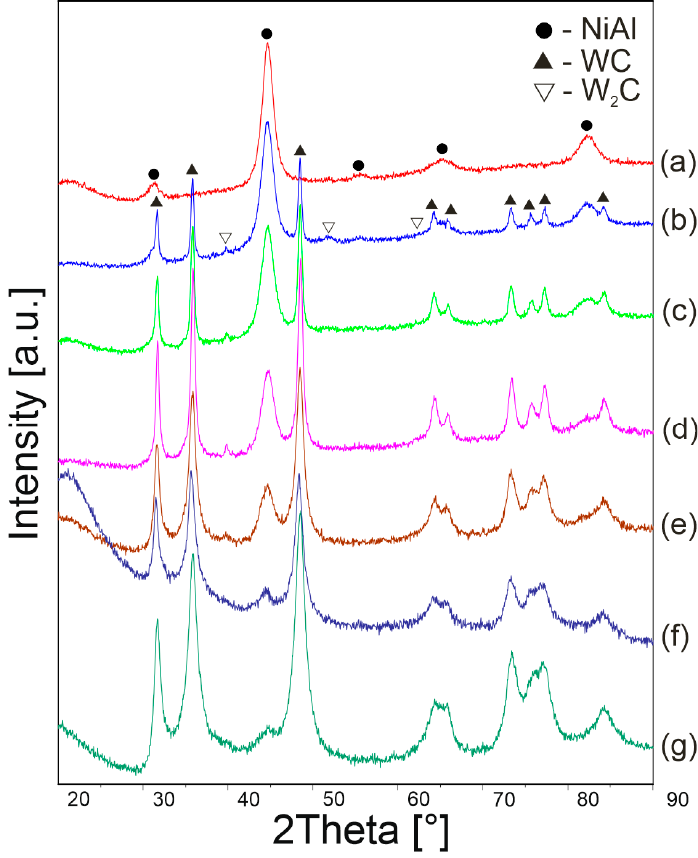
Figure 6. XRD patterns of NiAl (a), NiAl-10WC (b), NiAl-20WC (c), NiAl-40WC (d), NiAl-60WC (e), NiAl-80WC (f) and NiAl-90WC (g) powders after 10 h of MA. Table 3. Estimated size and strain factors based on Williamson–Hall plots for NiAl-xWC powders after 10 h of mechanical alloying.